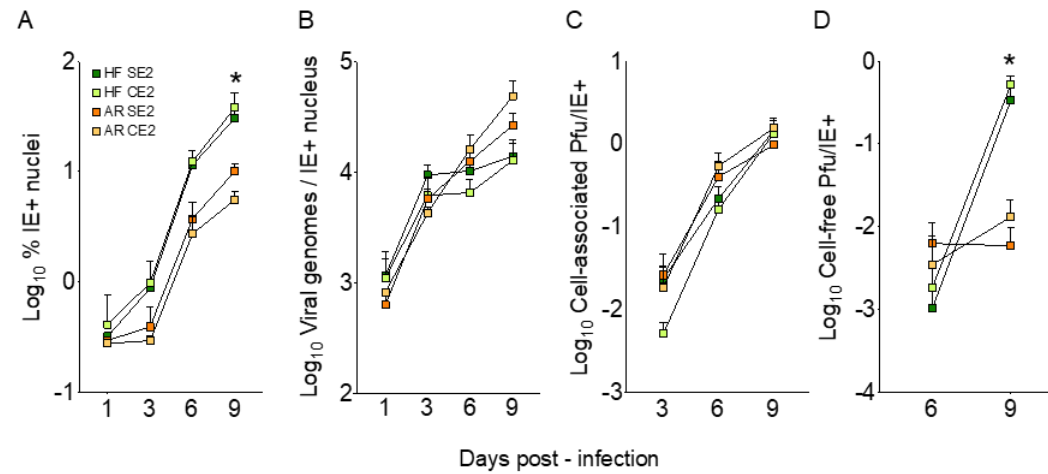
Figure 4. Replication of the SE2 and CE2 virus stocks in fibroblasts and epithelial cells. HFF and ARPE-19 cells were infected with each stock at an MOI of 0.01 pfu / cell and the ( A ) Proportion of nuclei expressing the IE1 / IE2 proteins, ( B ) Number of viral genome copies per IE + nucleus, ( C ) Amounts of cell-associated virus per IE + nucleus, and ( D ) Amounts of cell-free virus per IE + nucleus were determined. No cell-associated virus was detected at day 1, and no cell-free virus was detected at days 1 and 3. Graphs show mean ± standard deviation values from two ( B ) or three ( A , C , D ) independent experiments. * indicate statistically significant differences among samples.